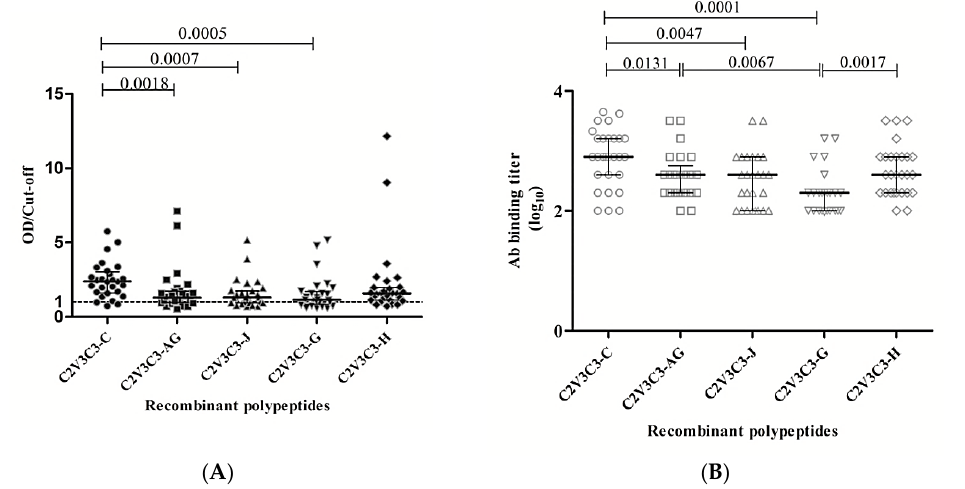
Figure 3. Antibody binding reactivity against recombinant C2V3C3 polypeptides from different subtypes. ( A ) Dot-plot graphic showing the median binding antibody reactivity (OD/Cut-off) and interquartile range of 28 plasma samples from HIV-1 infected individuals against recombinant polypeptides from HIV-1 clades C, G, H, J, and CRF02_AG; ( B ) Dot-plot graphic showing the median binding antibody titers and interquartile range. Kruskal – Wallis and Dunn´s multiple comparison tests were used to compare the distribution of binding antibody reactivity between subtypes. p values < 0.05 were considered statistically significant.